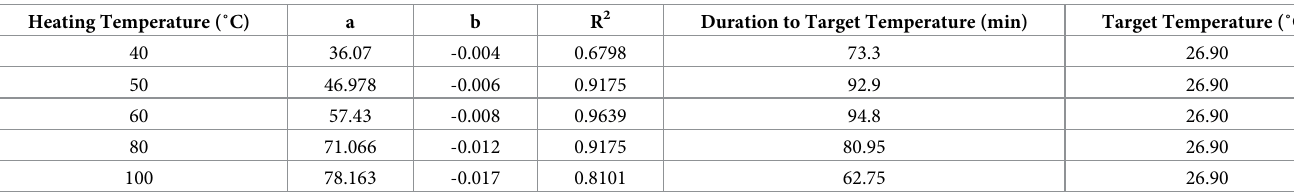
Table 1. Calculated durations to reach the target temperature of